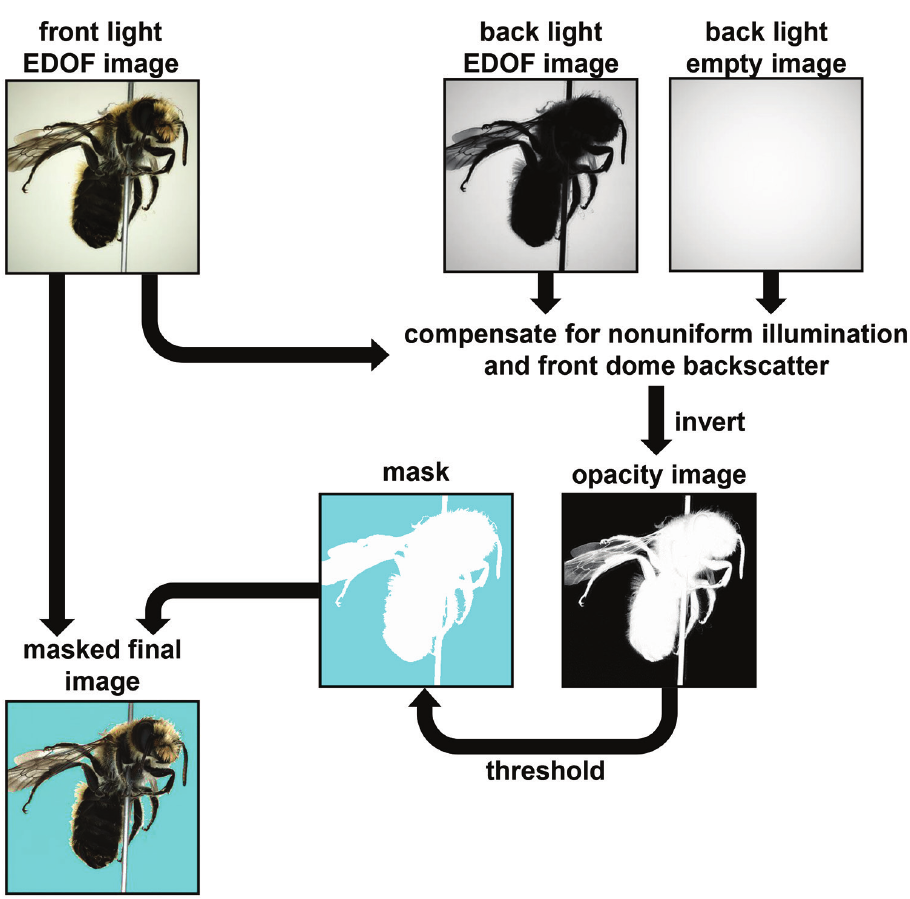
Figure 5. Workflow of image masking using front- and back-light